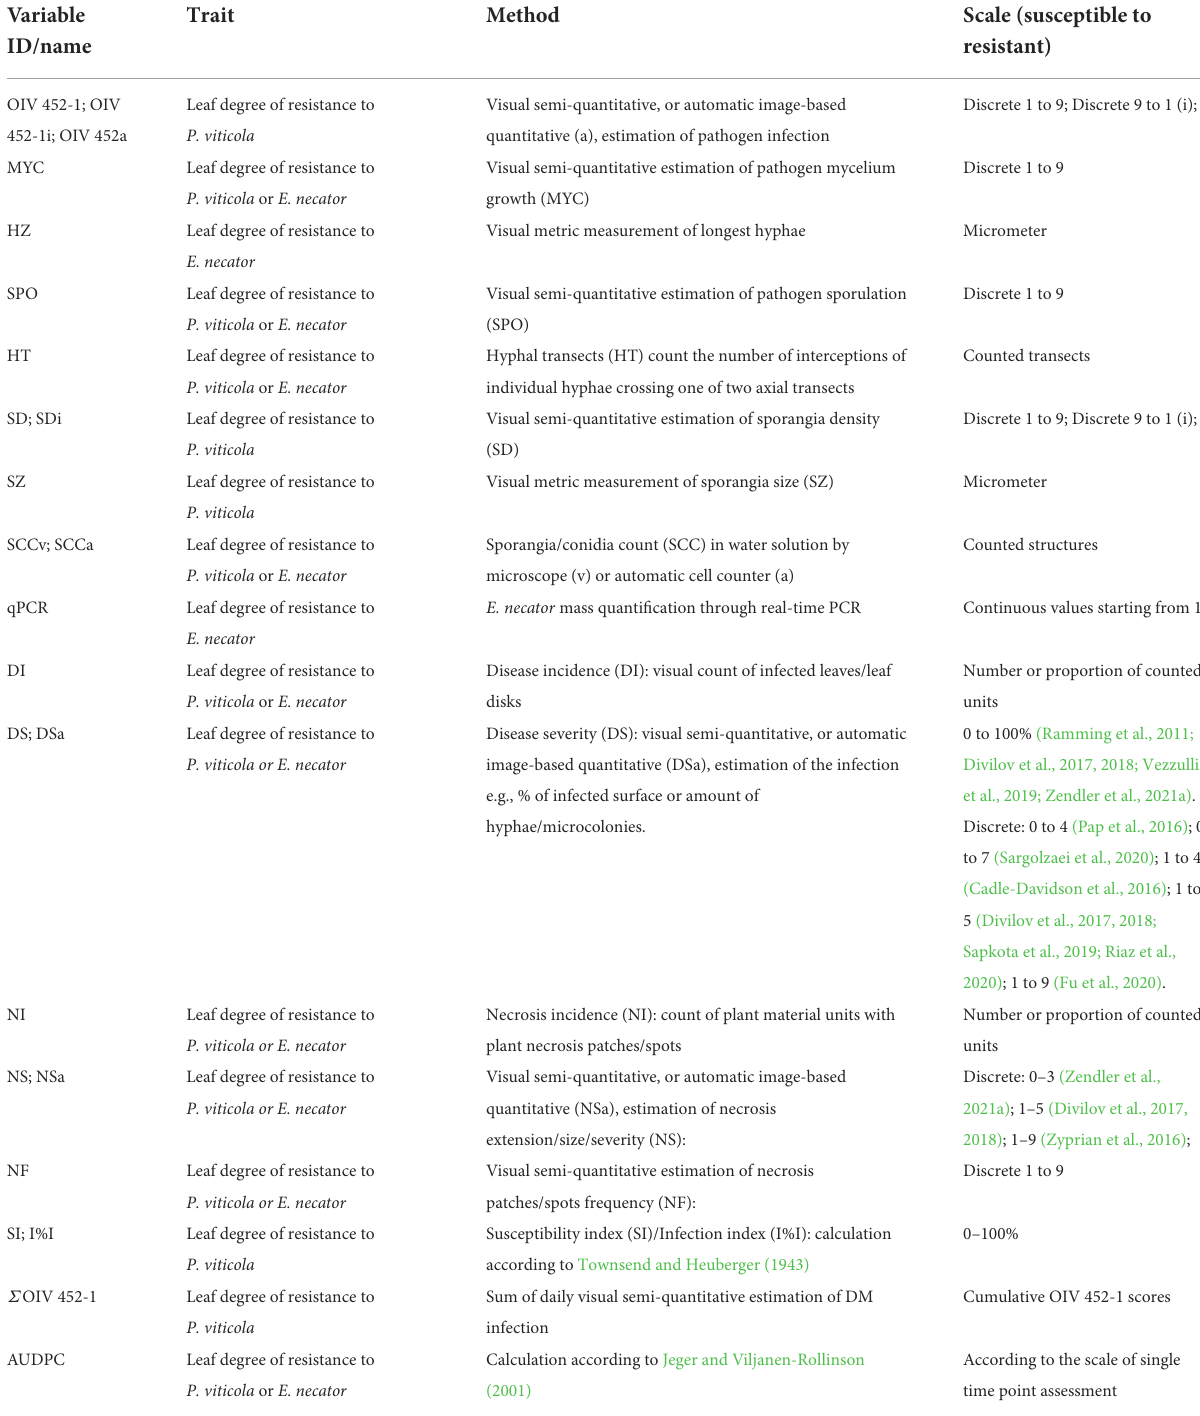
TABLE 6 Resistance variables assessed in the laboratory. An abbreviation and a description of the method and the scale utilized for the scoring are proposed for each resistance variable assessed in mapping studies.